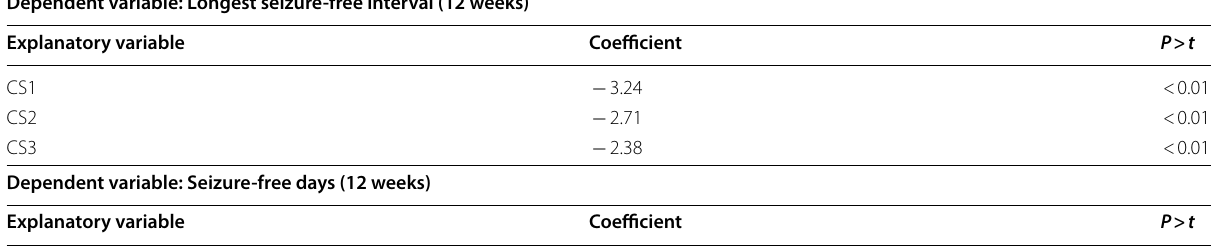
75). Notes See Table 1 for definition of composite scores 1, 2 and 3 =